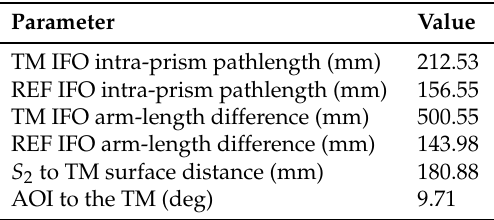
Geometrical parameters relevant to the structural analysis and noise investigations. AOI: angle of incidence.